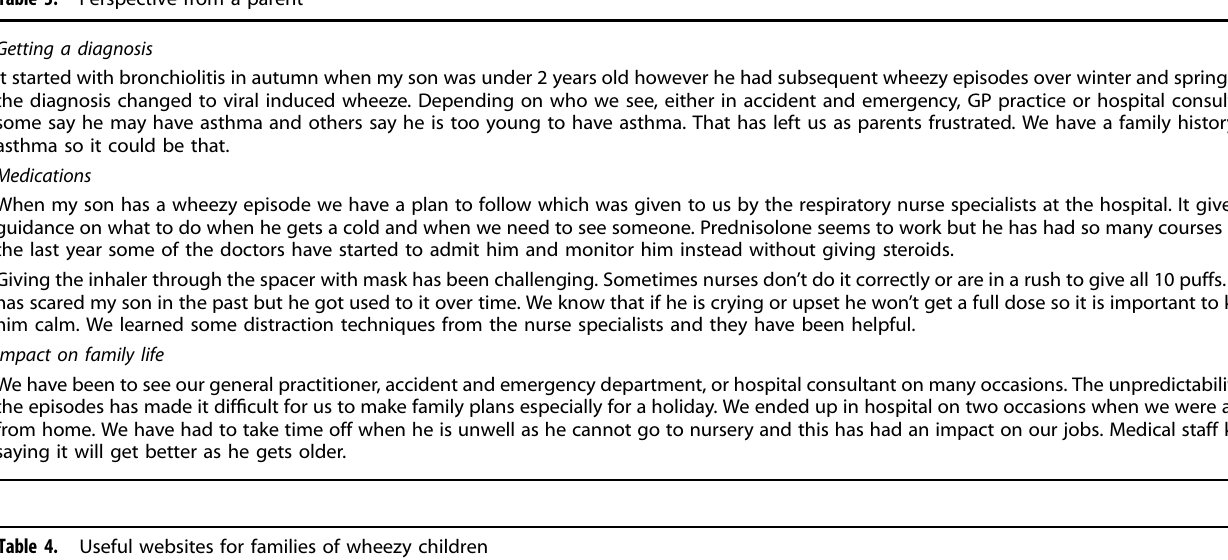
Table 3. Perspective from a parent Getting a diagnosis